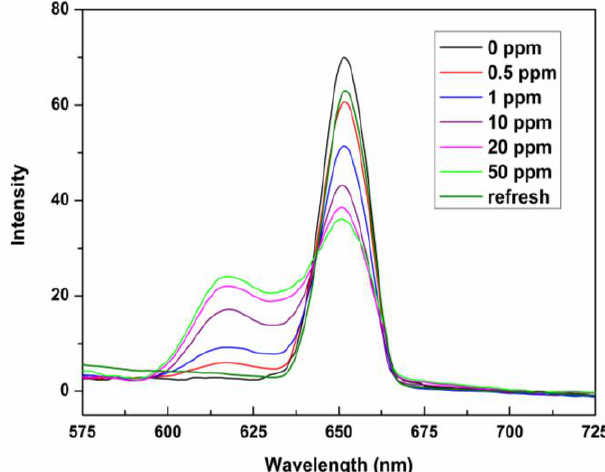
Figure 7. Fluorescence emission spectra of the ZPCPI nanofibrous membrane when exposed to different concentrations of pyridine vapor or recovered when puffed with N ( λ = 420 2 ex